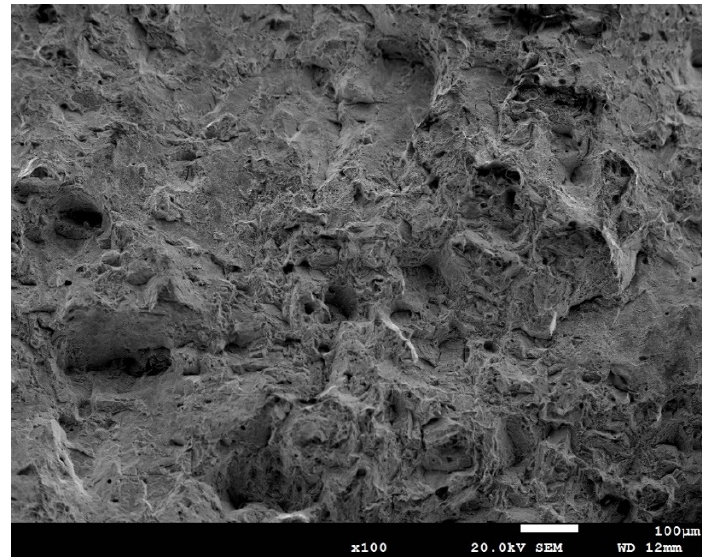
Figure 12. Fracture surface of specimen N5.